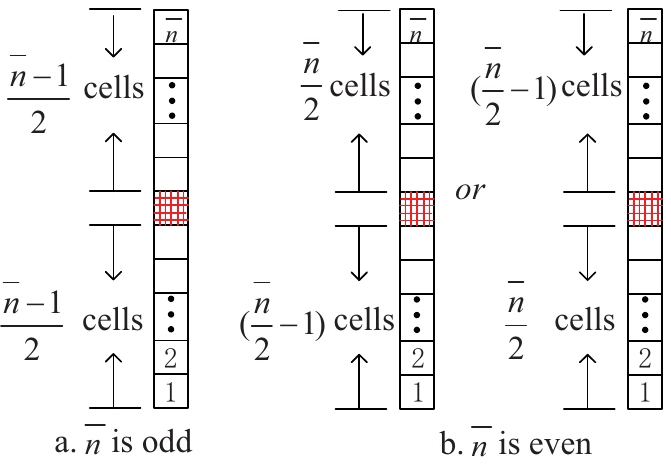
Figure 6. The cells chosen in the generalized